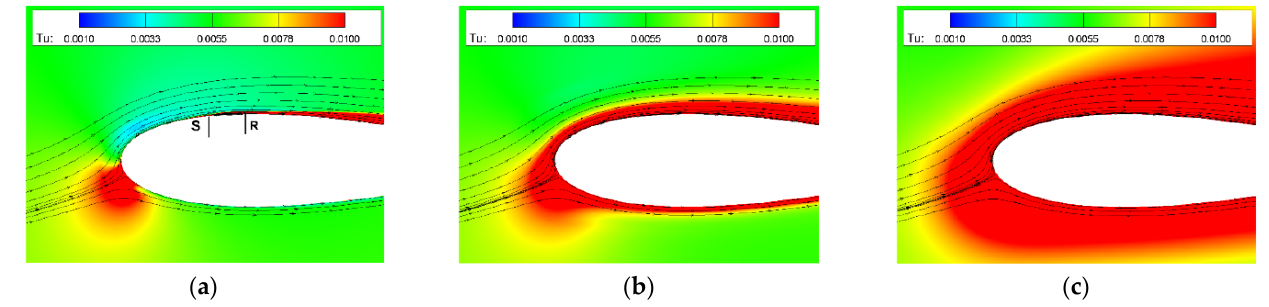
Figure 7. Computed turbulence intensity distribution and streamlines predicted by γ -Re θ t SST at α = 8°. ( a ) R T,FS = 0.1. ( b ) R T,FS = 1.0. ( c ) R T,FS = 10. (“S” denotes separation point and “R” denotes reattachment point.)